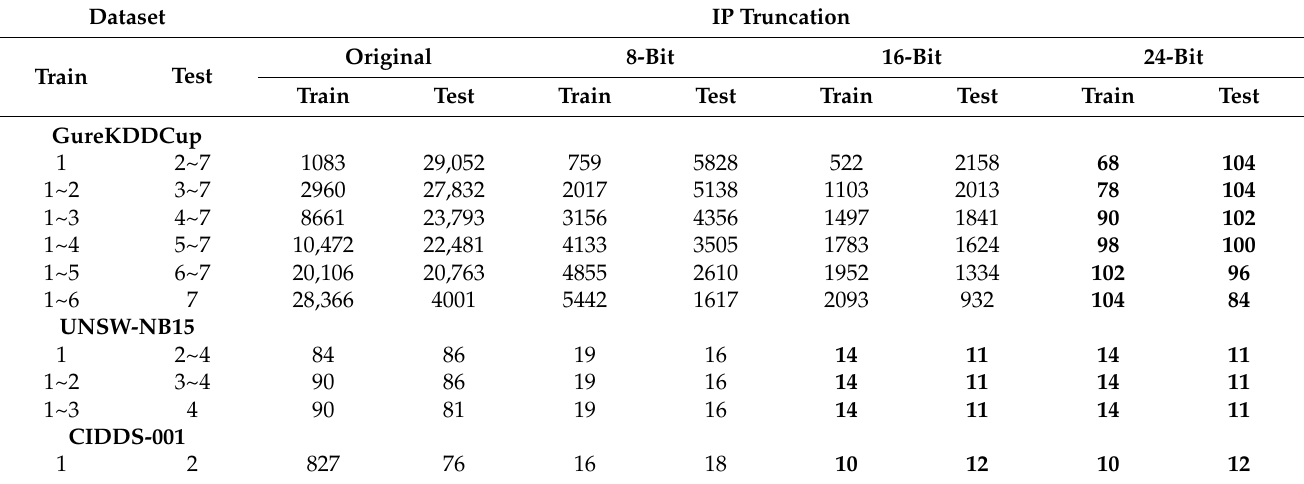
Table 7. Total Number of Distinct IP addresses (Sum of both Source and Destination IP) for each